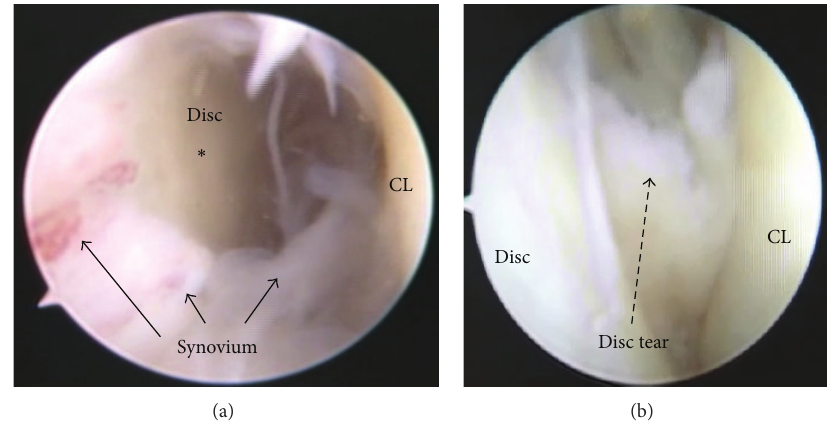
Figure 1: Arthroscopic images of the left sternoclavicular joint. (a) Inferior portal view showing synovial proliferation in the sternoclavicular joint (black arrows: synovium; a dot mark: intra-articular disc; CL: joint surface of the clavicle). (b) Inferior portal view showing a partial tear at the anterior part (a dotted arrow) of the intra-articular disc.